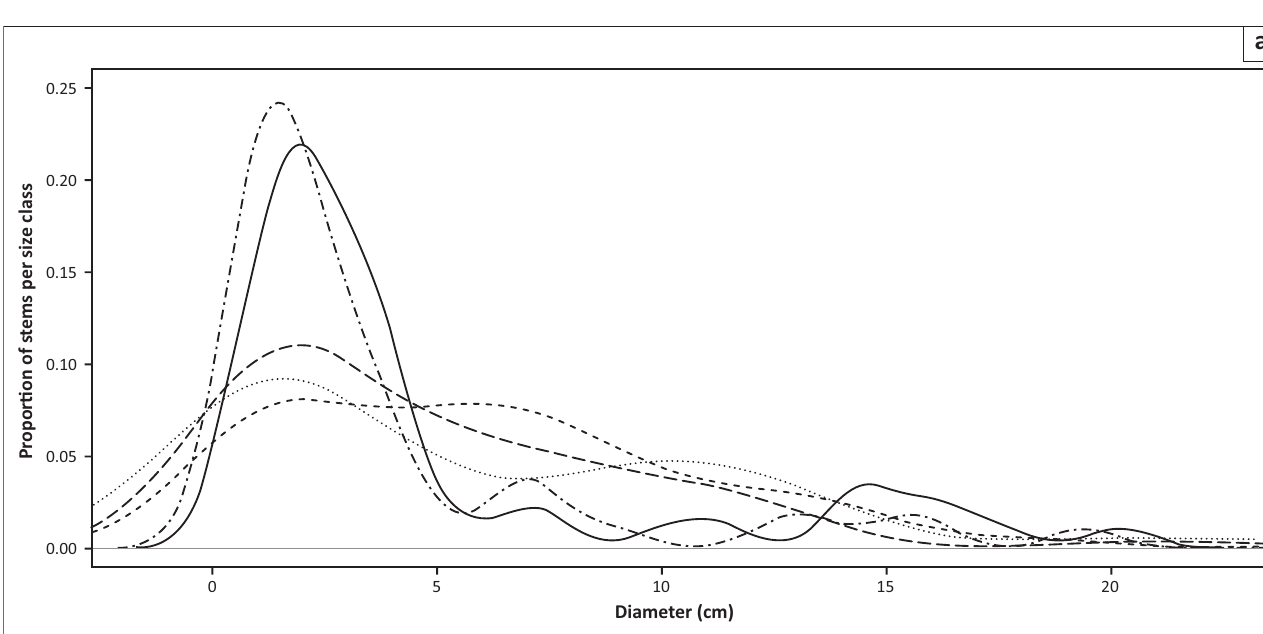
FIGURE 8: Density plot showing the variability in diameter size class distributions between sites: (a) Graskop sites and (b) White River sites (five sites for each location).